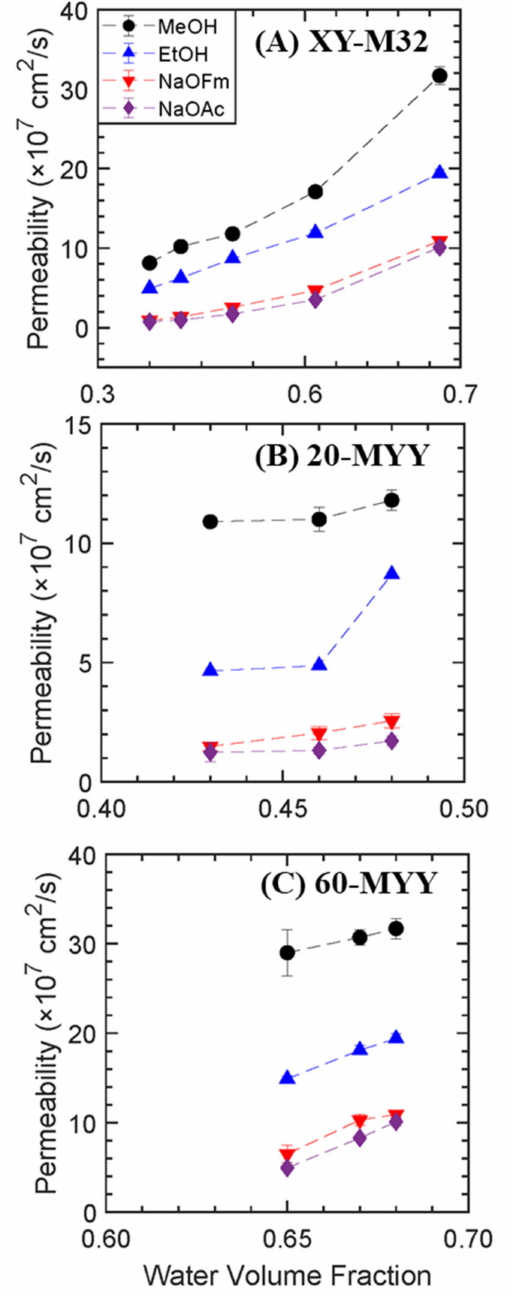
Figure 4. ( A ) Water volume fractions, and ( B ) crosslinking density for polymer films at 0, 10, 20, 40, and 60 wt% pre − polymerization water content, prepared with 32 mol% PEGMA ( ◆ , dash), water Figure 7. PEGDA-PEGMA permeability to MeOH ( • ), EtOH ( (cid:78) ), NaOFm ( (cid:72) ), and NaOAc ( single solute solution vs. water volume fraction ( A ) at varied pre − polymerization water content volume fractions of films at 0, 16, and 32 mol% (M) PEGMA content, prepared with 20 ( ● , solid) and constant 32 mol% PEGMA content (XY − M32) ( B ) at varied PEGMA content with 20 wt.% and 60 wt% ( ■ , dash) pre − polymerization water content.[the upper arrow indicates PEGMA pre − polymerization water content (20 − MYY), and ( C ) at varied PEGMA content with 60 wt.% mol% as an x-axis variable, and the lower arrow indicates pre − polymerization water wt.% as an x- pre − polymerization water content (60 − axis variable]